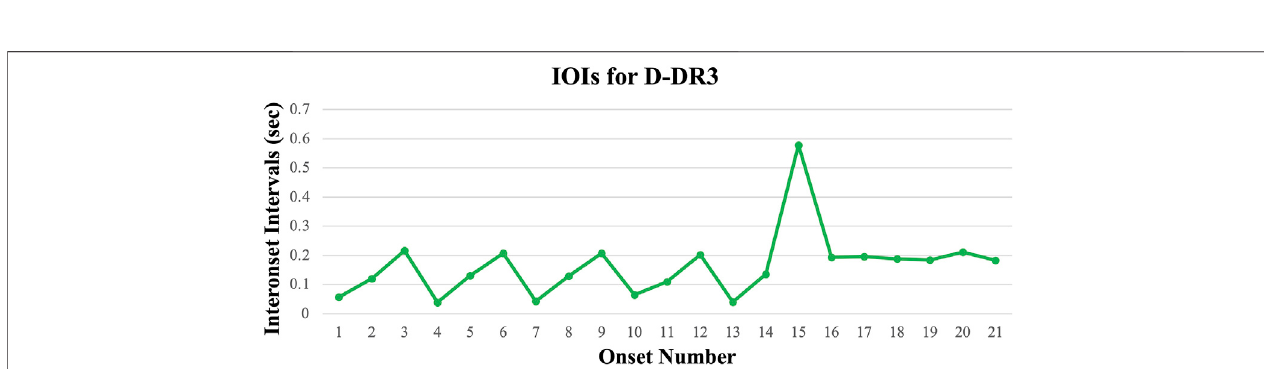
FIGURE 4 | Interonset intervals (IOIs) for a typical vocal singing sample (VS) and the corresponding imitation of the song on the drum (DS). Present in the graph of DS are rhythmic embellishments that shift the timing pro fi les of DS and VS out of alignment (see sound samples Supplementary Samples 2A,B ).